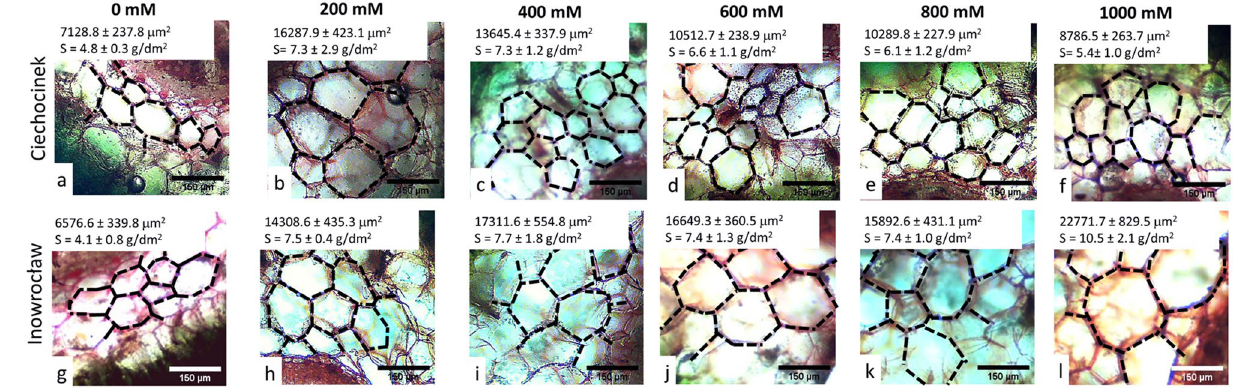
Figure 1. Stem-cortex cell’s area changes of S. europaea after 2 months in Cie ( a–f ) and Inw ( g–l ) populations grown under different NaCl concentrations. Scale bar 150 μm. n = 300 ± 50 cells, 12 individuals per treatment. S: correspond to the degree of succulence in the stems 17,24 . The F value of S that corresponds to the 2-way ANOVA for the interaction salt treatment × population is F 5,48 = 5.5; p <